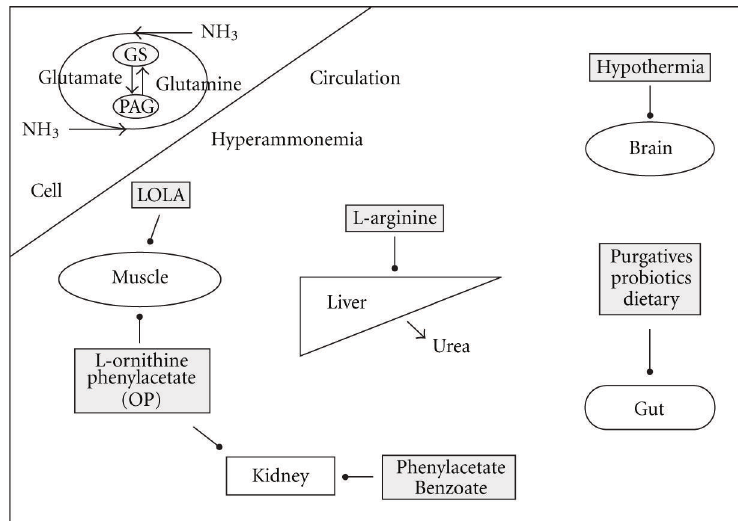
Figure 1: Therapies manipulating interorgan ammonia and amino acid metabolism. In liver failure, the relative activities of cellular glutamine syntheses (GS) and phosphate-activated glutaminase (PAG) in di ff erent organs influence interorgan ammonia and amino acid metabolism. With a loss of hepatic urea cycle capacity, hyperammonaemia is predominately due to worsening intestinal and renal ammonia e ffl ux, with skeletal muscle having the potential to increase its ability to detoxify ammonia. Though the brain also detoxifies ammonia, this is counterproductive as resultant astrocyte glutamine accumulation induces brain swelling. This schematic highlights not only current standard therapies for hyperammonaemia which principally act on individual organs (e.g., purgatives targeting intestinal ammonia production), but also newer interventions targeting multiple organs (e.g., LOLA and